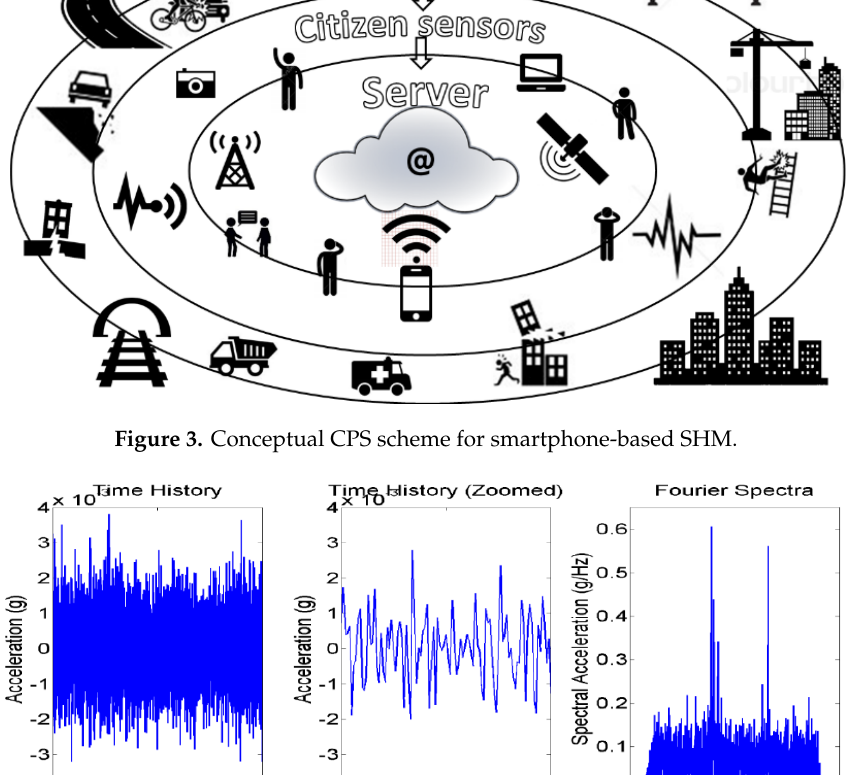
Figure 3. Conceptual CPS scheme for smartphone-based SHM.